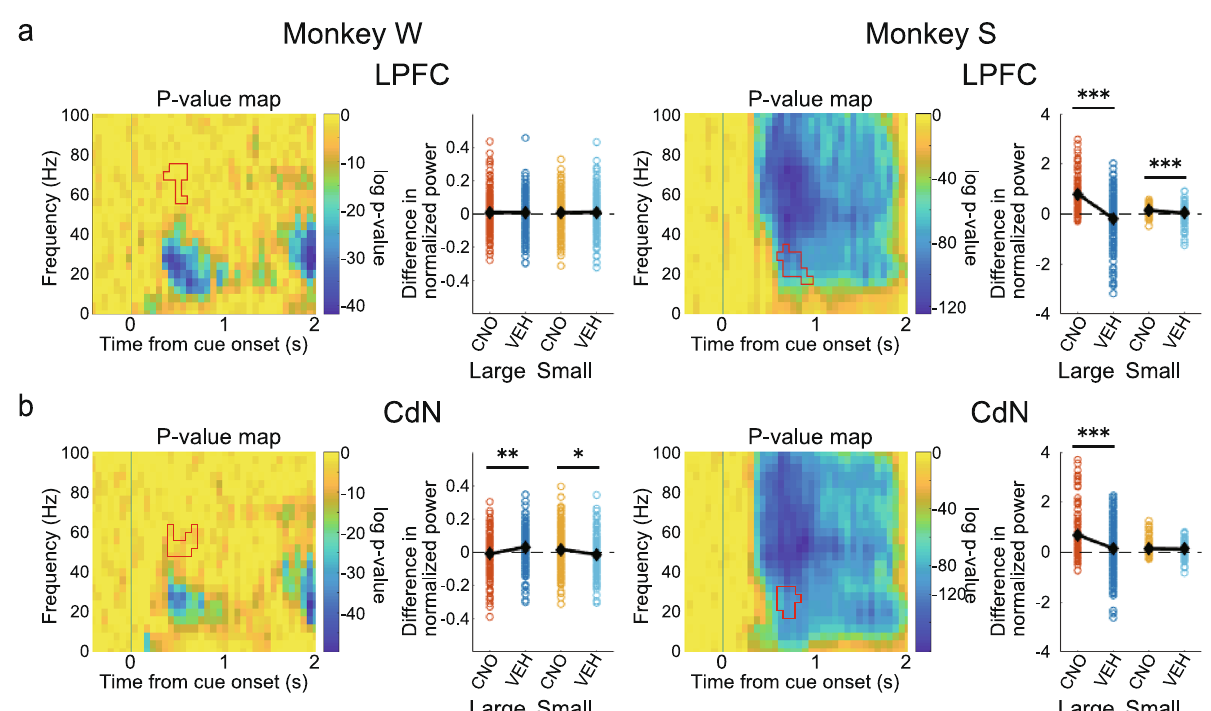
Fig. 6 CNO effects after cue onset on different frequency bands. Time-frequency analysis using ROIs exchanged between two monkeys to study the effect of CNO administration on different frequency bands. a CNO effects in the LPFC. For each monkey: left: p -value map and the ROI identi fi ed in the spectrograms of the other monkey with the time adjusted to the onset of the original ROI; right: comparison of effects of CNO/VEH administration (Pre – Post) using the other monkey ’ s ROI depicted in the left panel. b CNO effects on the CdN. All features in this panel are the same as in Fig. 4b. CdN caudate nucleus, CNO clozapine N-oxide, VEH vehicle, LPFC lateral prefrontal cortex, ROI region of